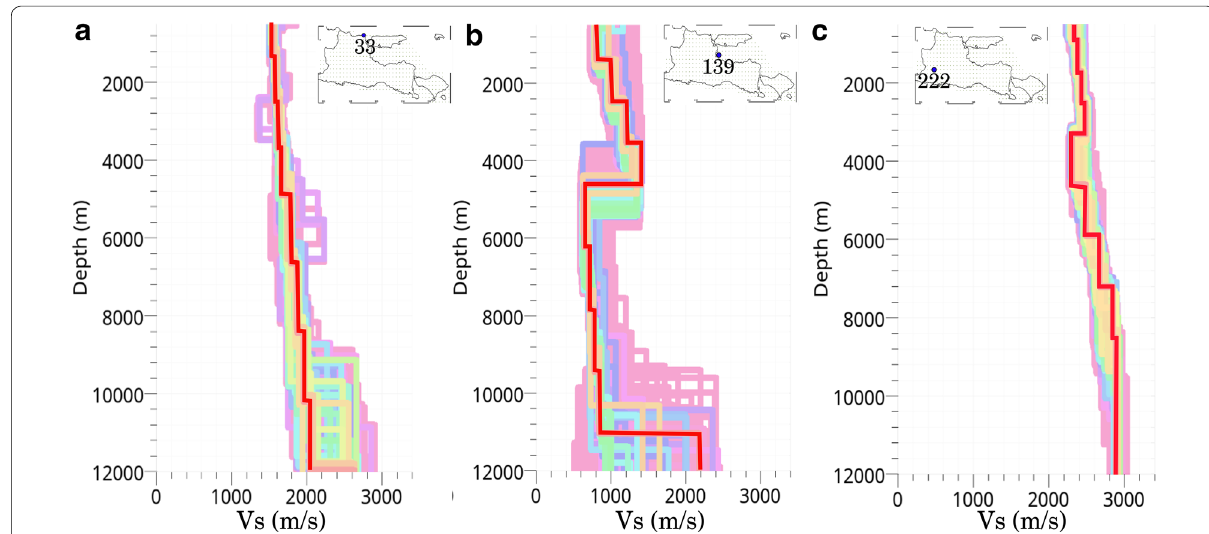
Fig. 7 Depth profile of shear wave velocity and dispersion curve obtained using the Neighborhood Algorithm at points a 33, b 139, and c 226. The color of the model space represents the density distribution of samples. The solid red and dashed lines in the middle correspond to the weighted average and the best fitting models, respectively